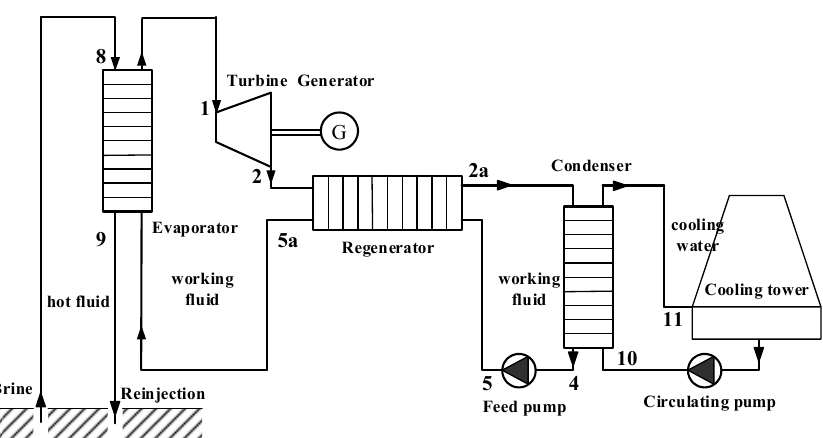
Figure 1. Schematic layout of the regenerative cycle.